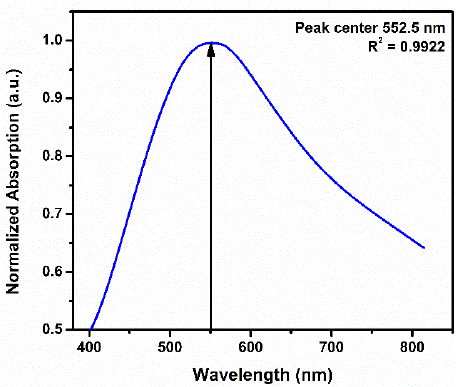
Figure 4. LSPR response of the AgNP deposited on polystyrene cuvette.